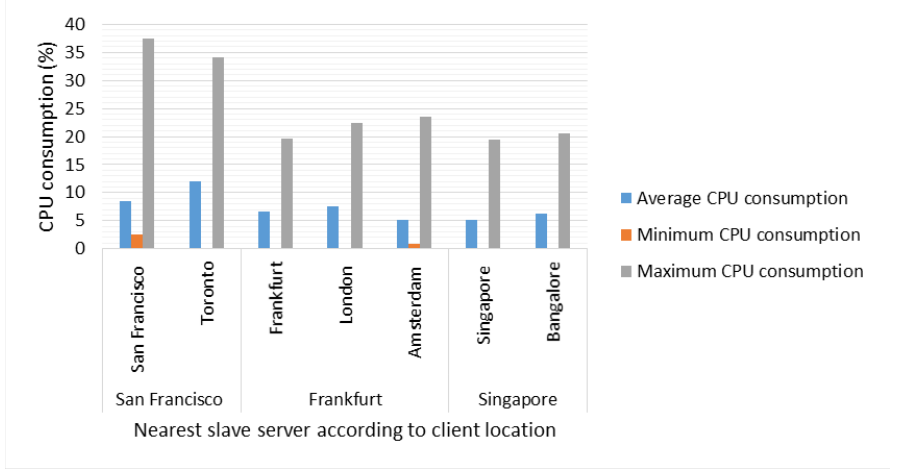
Figure 12. Average CPU consumption by client